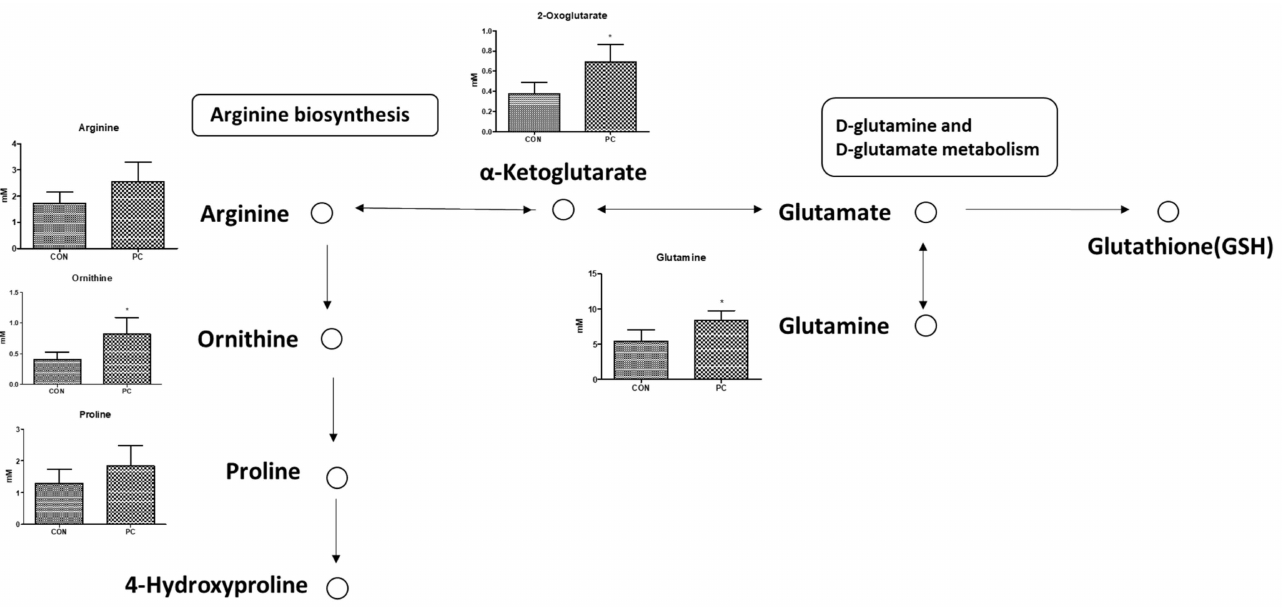
Figure 8. Expected serum metabolic pathway by second-hand smoke exposure. Error bars are expressed as S.D. *, p <